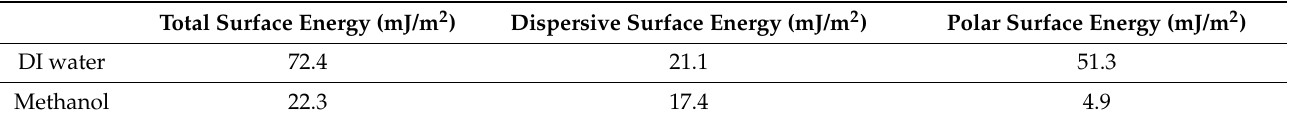
Table 2. Surface energy components of DI water and